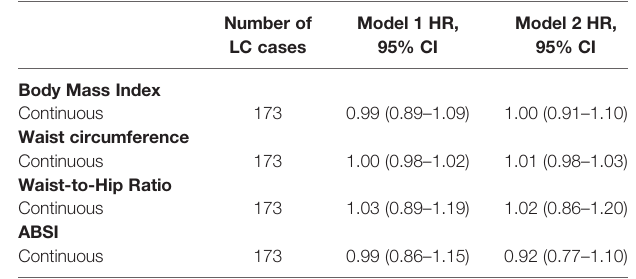
TABLE 5 | Hazard ratio ’ s (95% CI) for the mean differences of BMI (kg/m 2 ), WC (cm), WHR, and ABSI between baseline and follow-up with the risk of lung cancer.